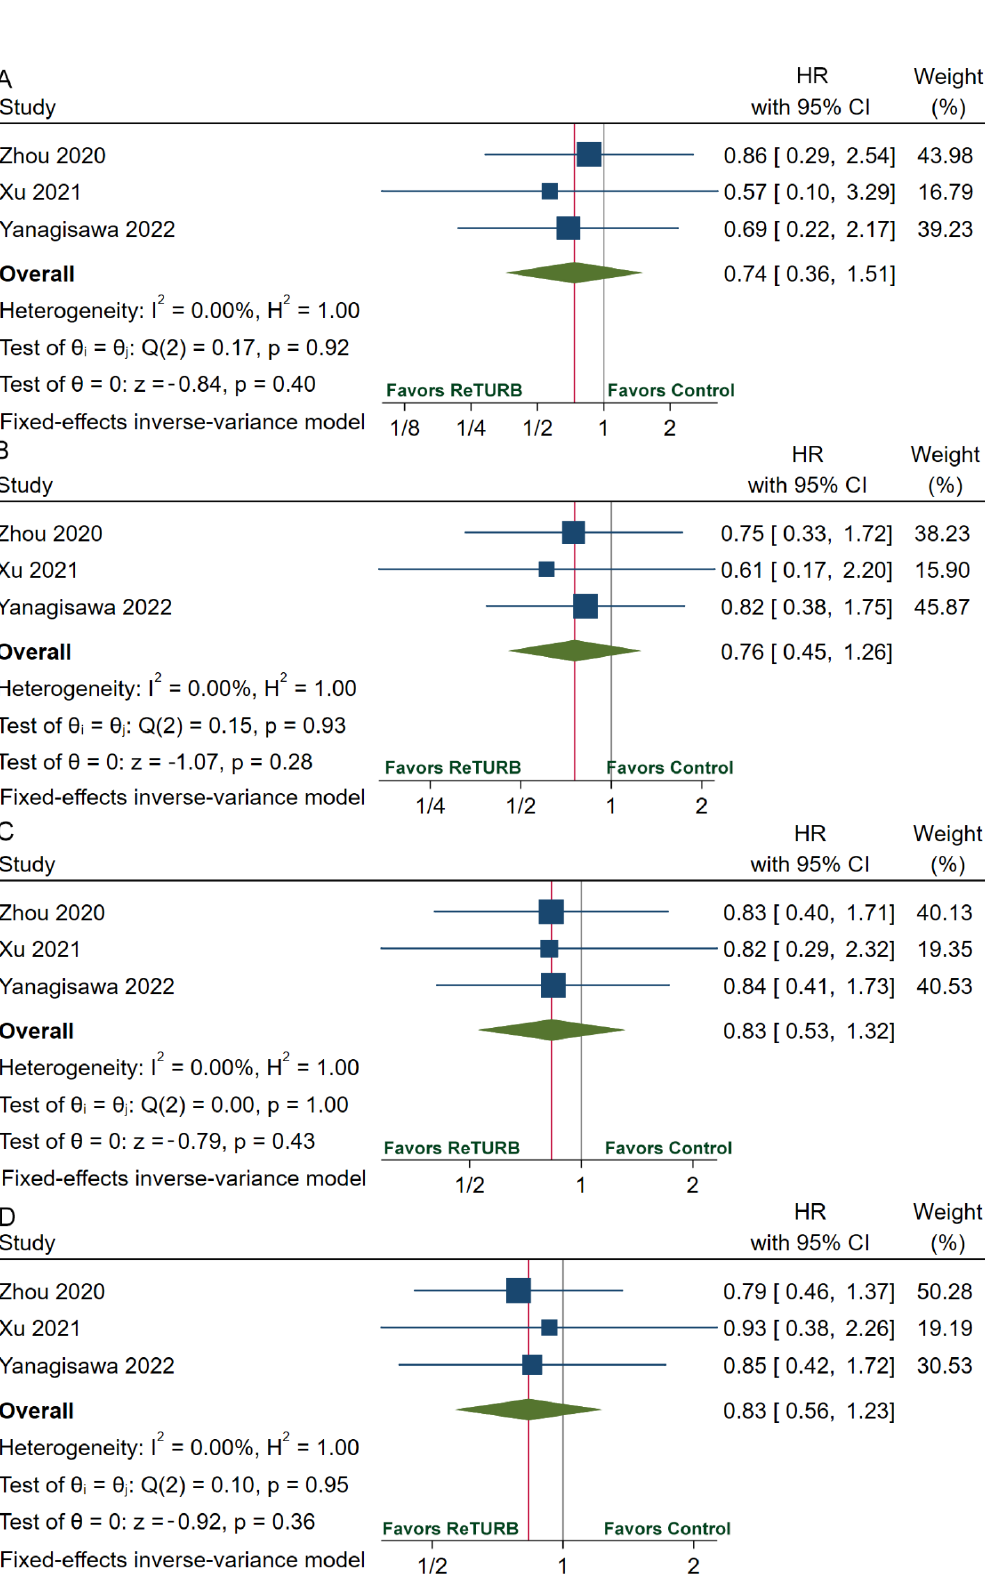
Figure 3. Forests plots of comparisons of 1-year RFS ( A ), 2-year RFS ( B ), 3-year RFS ( C ), and 5-year RFS ( D ) between the reTURB group and control group [32,36,38]. The gray lines represent the reference lines and the red lines show the pooled effect sizes. RFS: recurrence-free survival; HR: hazard ratio; reTURB: repeat transurethral resection of bladder tumors; CI: confidence